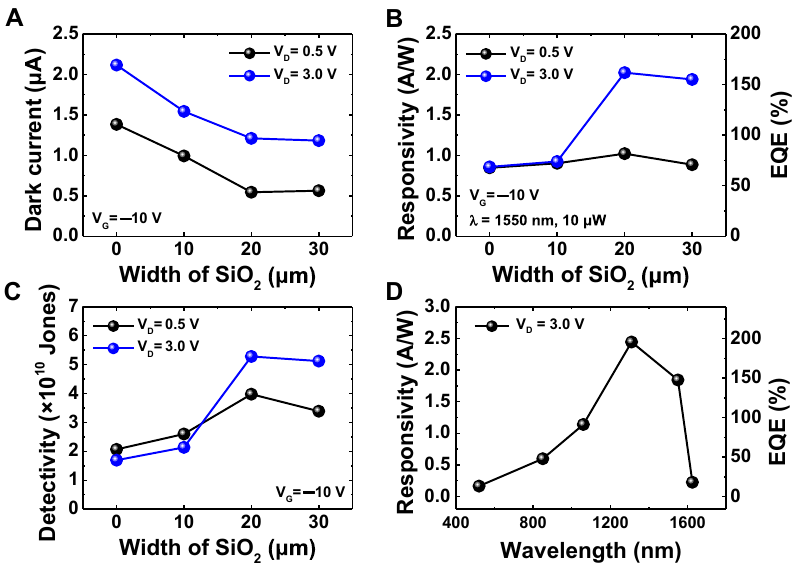
Figure 4: (A – C) Performance comparison of split active junction photodetectors as a function of SiO 2 width: (A) dark current measured at V D = 0.5 and 3 V under V − 10 V; (B) responsivity (left axis) with G = calculated EQE (right axis); (C) speci fi c detectivity measured at a wavelength of 1550 nm with an incident light power of 10 μ W. (D) Wavelength-dependent respon- sivity (left axis) and EQE (right axis) of the split active junction photodetector measured at a fi xed light intensity of 25 μ